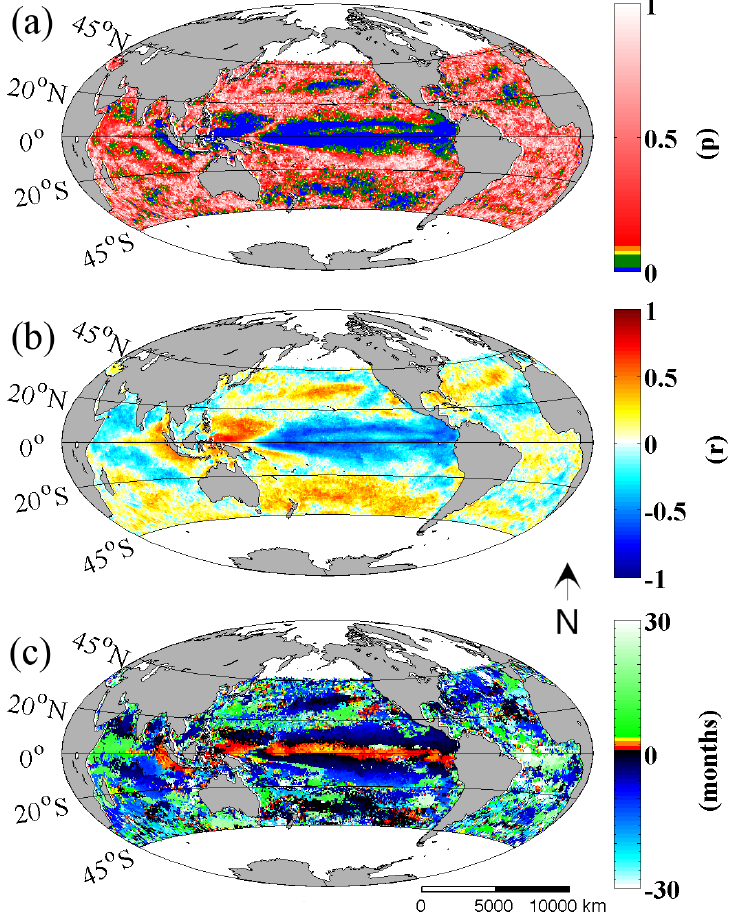
Figure 2. ( a ) Significance (p-value) of the probability that the Multivariate El Niño—Southern Oscillation Index (MEI) has the same distribution as the Chl -a time series calculated, with reduced number of intervals. Green values are between 0.01 and 0.1; ( b ) Correlation coefficient (r) when testing the relationship between the MEI and Chl -a time series; ( c ) Time lag (months) of best correlation coefficient (r) between the MEI and Chl time series. Positive values mean that Chl -a